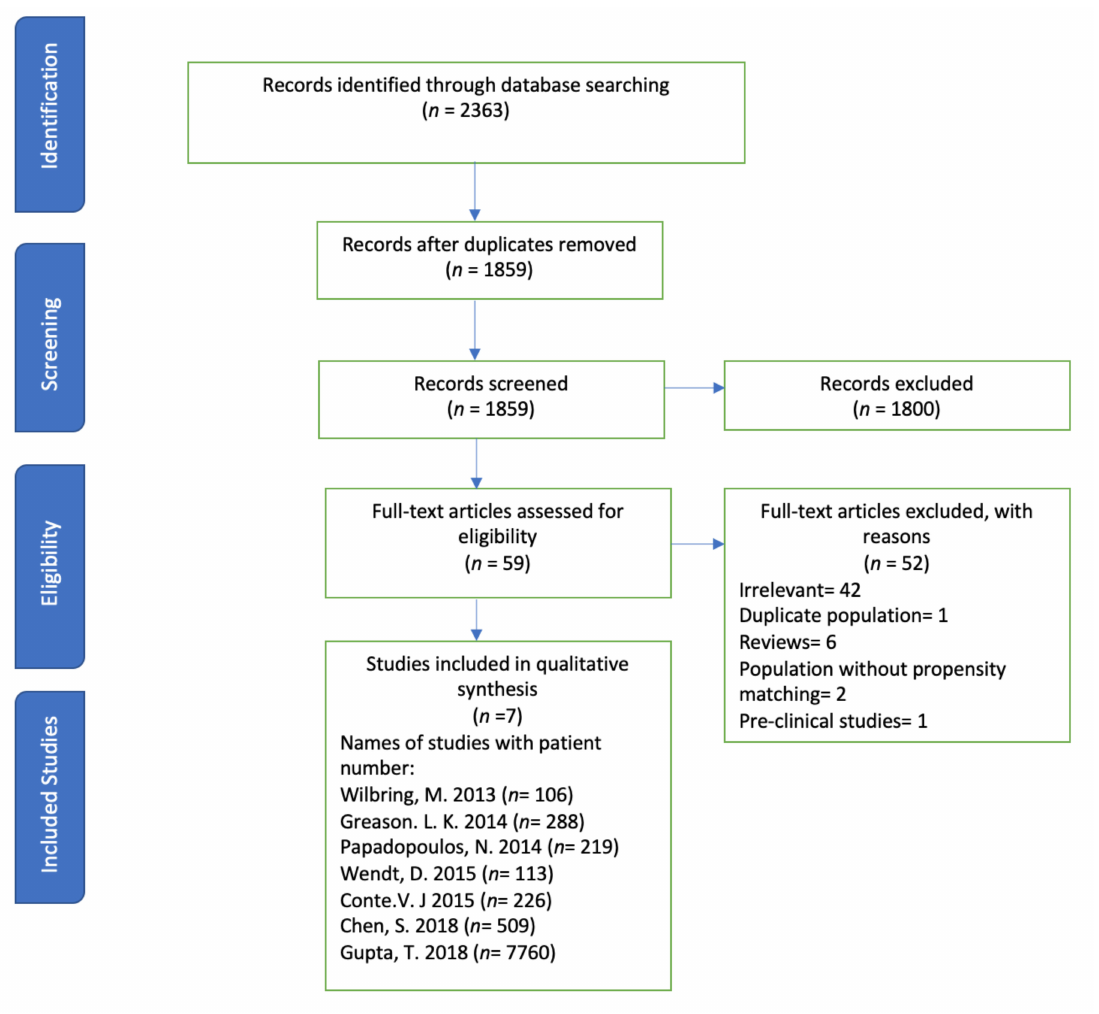
Figure 1. PRISMA flow showing the selection process of